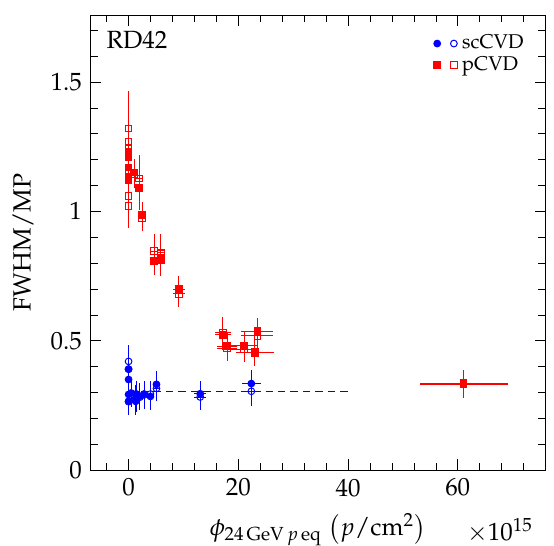
Figure 16. The FWHM/MP of scCVD and pCVD diamond samples irradiated with 24GeV protons, 800MeV protons, 70MeV protons, fast reactor neutron, and 200MeV pions for positive (solid markers) and negative bias (open markers) at E = 2V/µm. The fluence of each point was scaled by the relative damage constant to the 24GeV proton equivalent fluence. The dashed line represents a constant fit to the scCVD diamond data points (blue) extrapolated to 40 10 15 p /cm 2 for illustrative ×